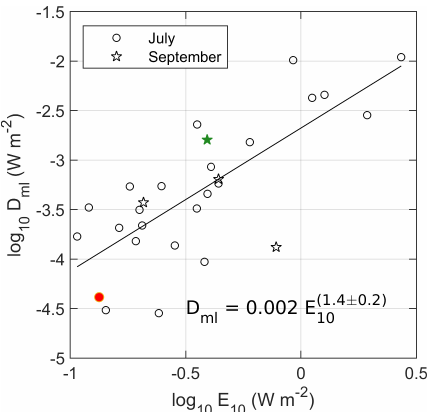
Figure 6. Depth-integrated dissipation rate in the mixed layer, D ml , as a function of the wind energy input to the mixed layer, E 10 . Stars and circles are data from the September and July cruises, re- spectively. The red circle is the data point from the RS2 process station where nonlinear internal waves were observed (Fer et al., 2020b). The green star is the data point at the process station at a front in September where convection was also important (Koenig et al., 2020). The black line is the regression line, with the equation indicated. The uncertainty is the 95% confidence